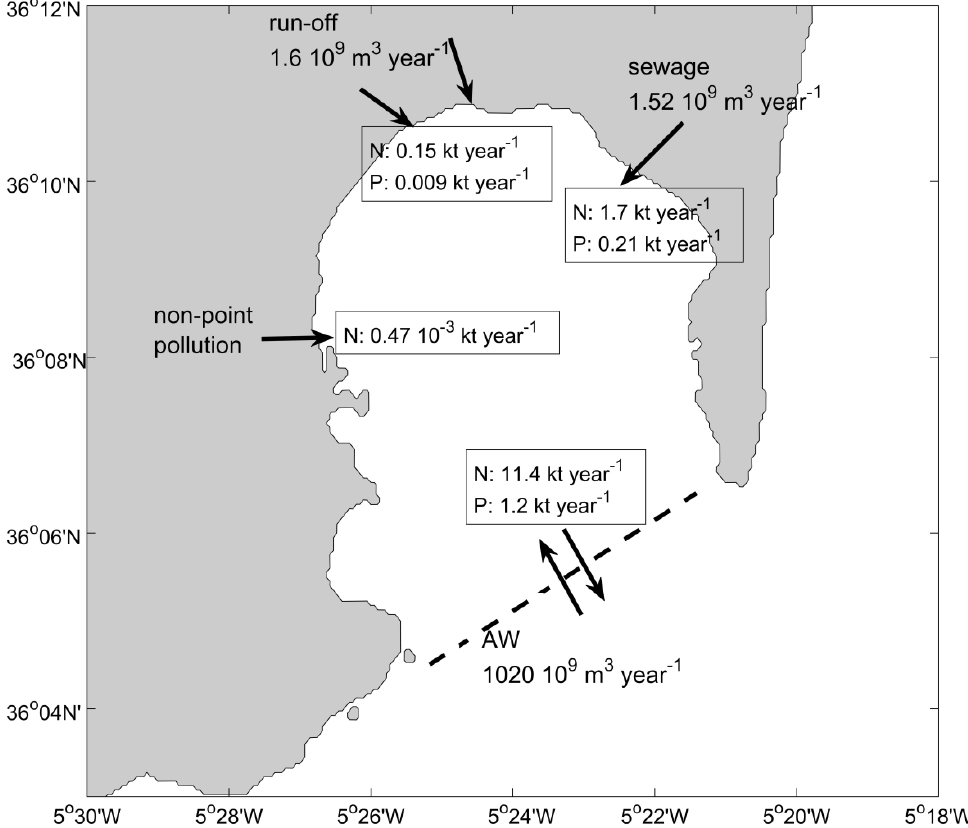
Figure 10. Estimation of yearly exchange of nitrate and phosphate between the outside and inside of the Bay of Algeciras (BA) associated to the Atlantic water flux (AW) and annual load of nitrogen and phosphorous from sewage, river discharge and non-point pollution sources. The overall amount of water associated to these sources (units: m 3 year − 1 ) is also shown (data from the non-point pollution not available).